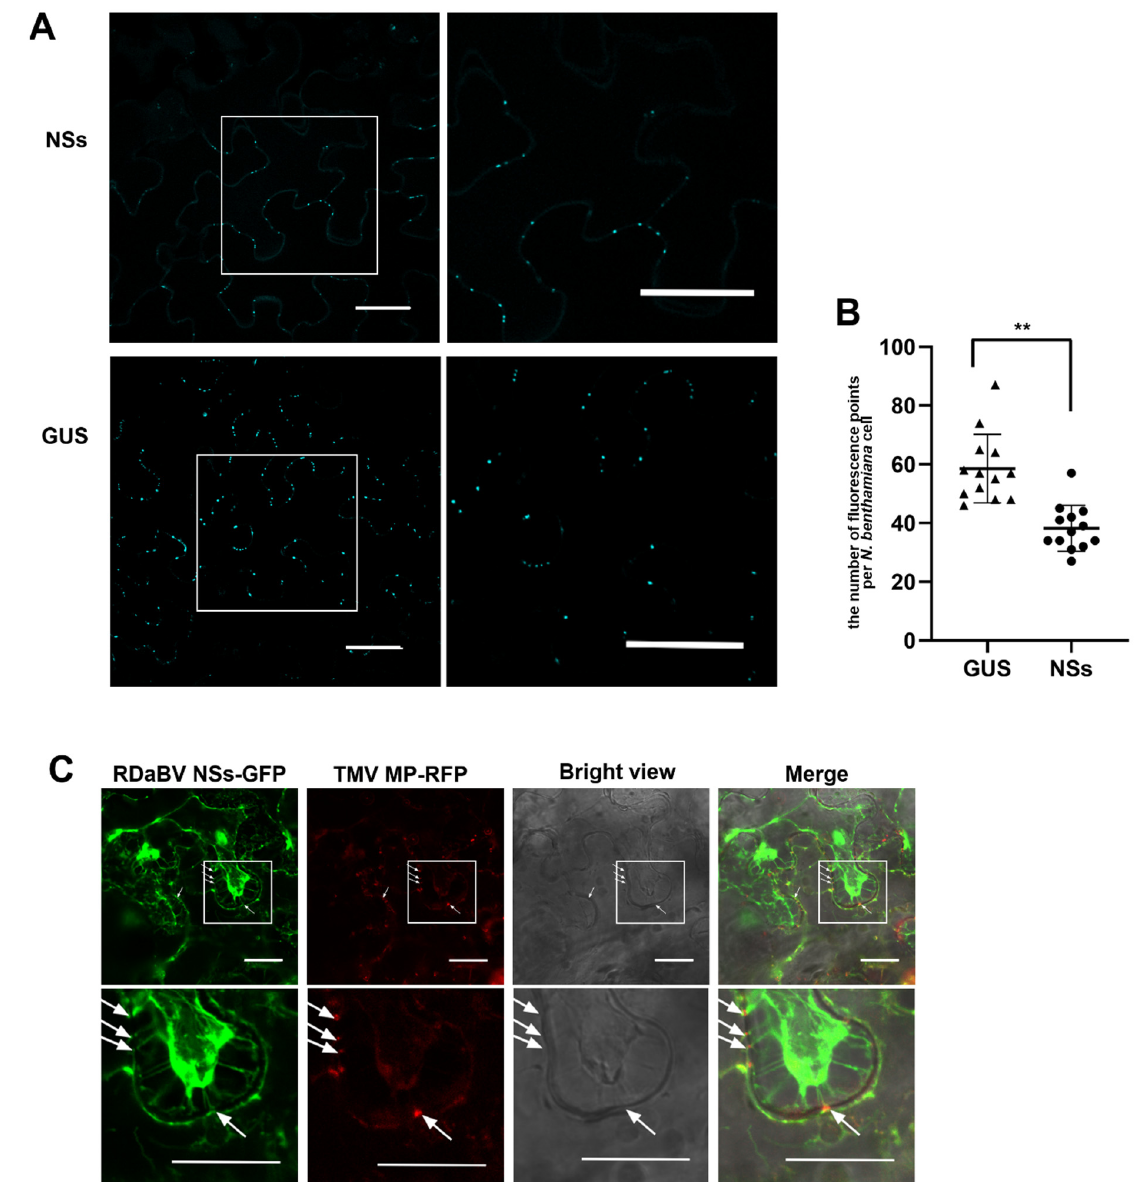
Figure 7. RDaBV NSs can reduce the callose deposition and locate plasmodesmata. ( A ) Aniline blue staining of callose of the leaves expressing RDaBV NSs. The right column shows the enlarged im- ages of the boxed areas in the images in the left column. Bars, 100 µm. ( B ) Statistics of fluorescence puncta in a single cell of N. benthamiana leaves expressing NSs and GUS . The triangles and dots indicate the number of puncta in a single cell of N. benthamiana leaves expressing GUS and NSs , respectively. Error bars showed the SD for 13 individual cells; ** p < 0.01 by t-test analysis. ( C ) Colo- calization of RDaBV NSs-GFP and TMV MP-RFP in co-infiltrated N. benthamiana leaves was ob- served using laser confocal microscopy. The leaves were treated with 1 M sucrose solution at 2 dpi. White arrows indicate the plasmodesmata positions. The lower row is the enlarged image of the boxed area in the upper image. Bars, 20 µm. 3.6. RDaBV NS Protein Roles as an RNA Silencing Suppressor